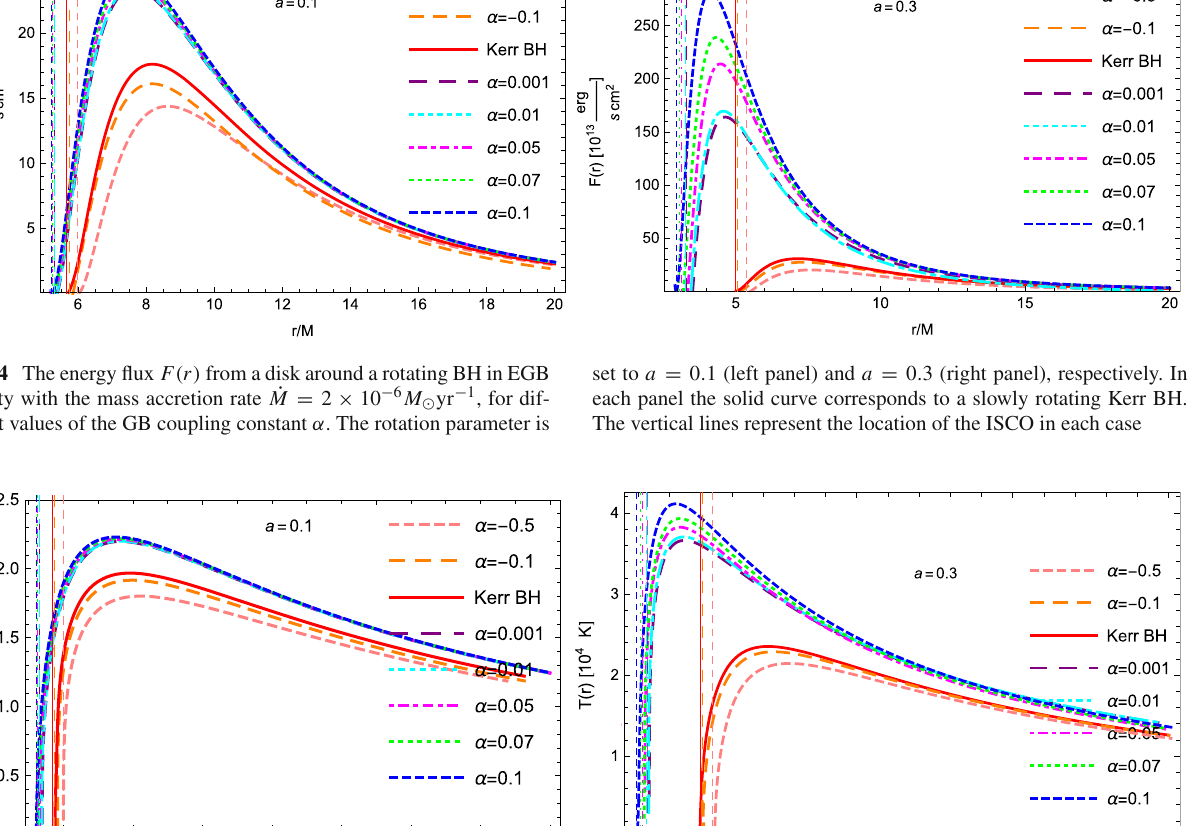
(right panel), respectively. In each panel the solid curve corresponds to a slowly rotating Kerr BH. The vertical lines represent the location of the ISCO in each case